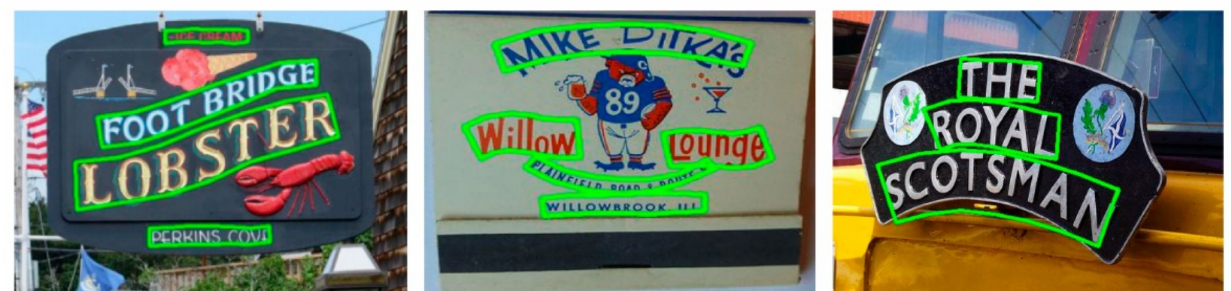
Figure 7. Some qualitative results of the proposed method on